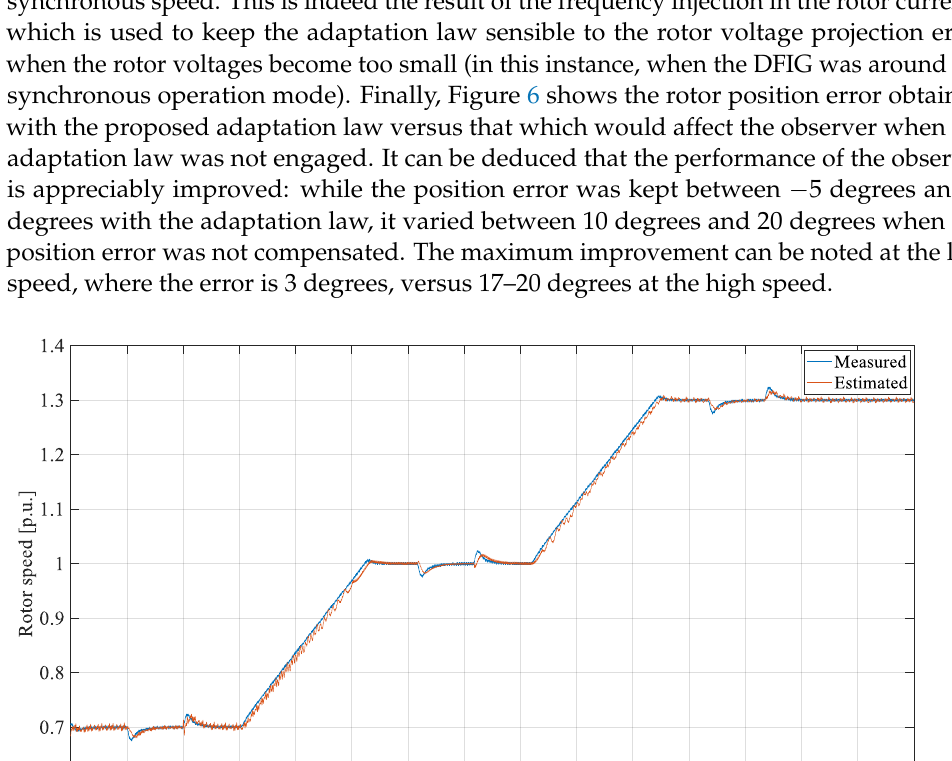
Figure 6. Behavior of the position estimation error with/without adaptation law in the whole test.